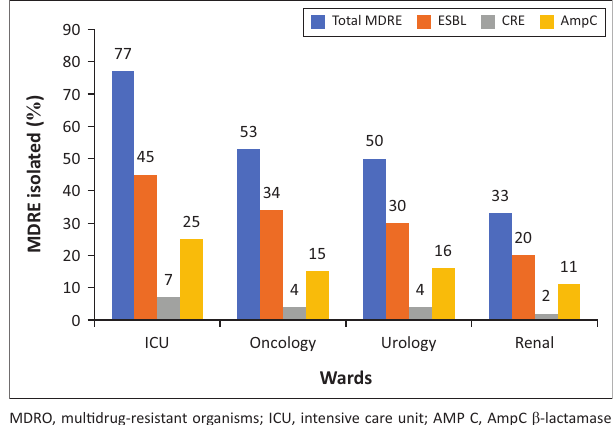
FIGURE 3: Multidrug-resistant enterobacteriaceae urinary isolates at high risk units for MDRO.